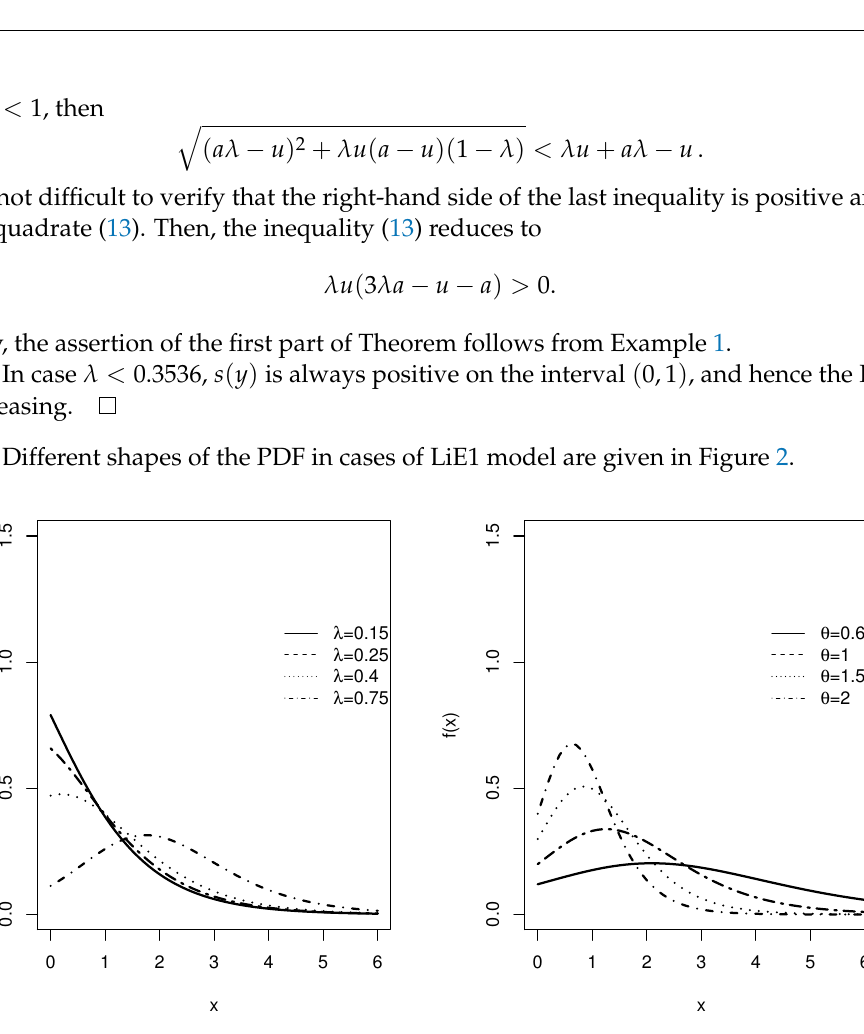
Figure 2. The plots of the density function of the LiE1 distribution for various choices of parameters with θ = 1 ( left ) and λ = 0.65 ( right